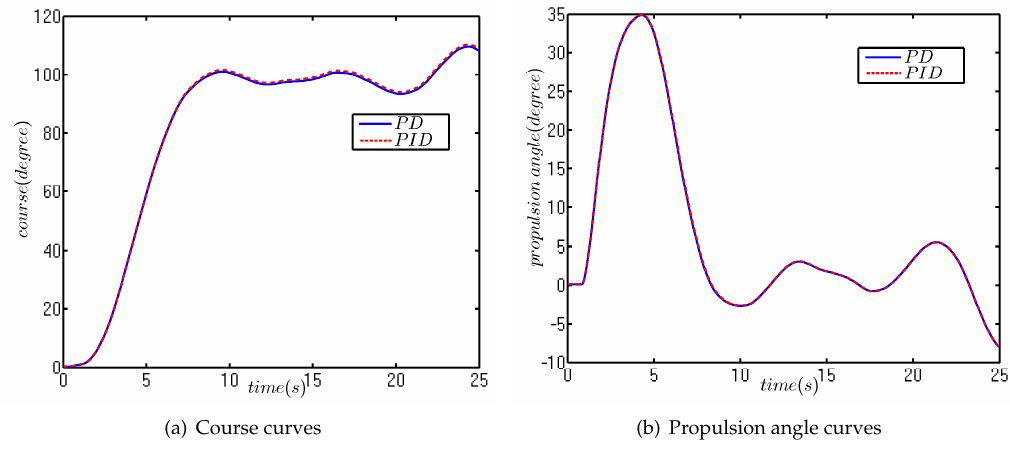
Figure 12. The numerical simulation of course